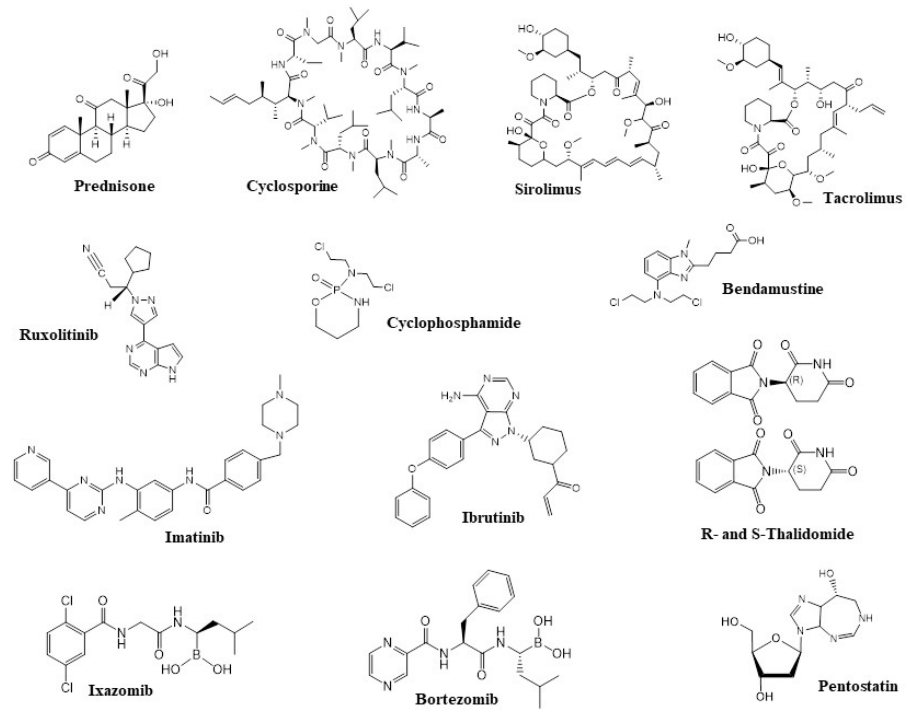
Figure 2. Structures of active components of the drugs currently used for the treatment of GVHD or in drug candidates under development.